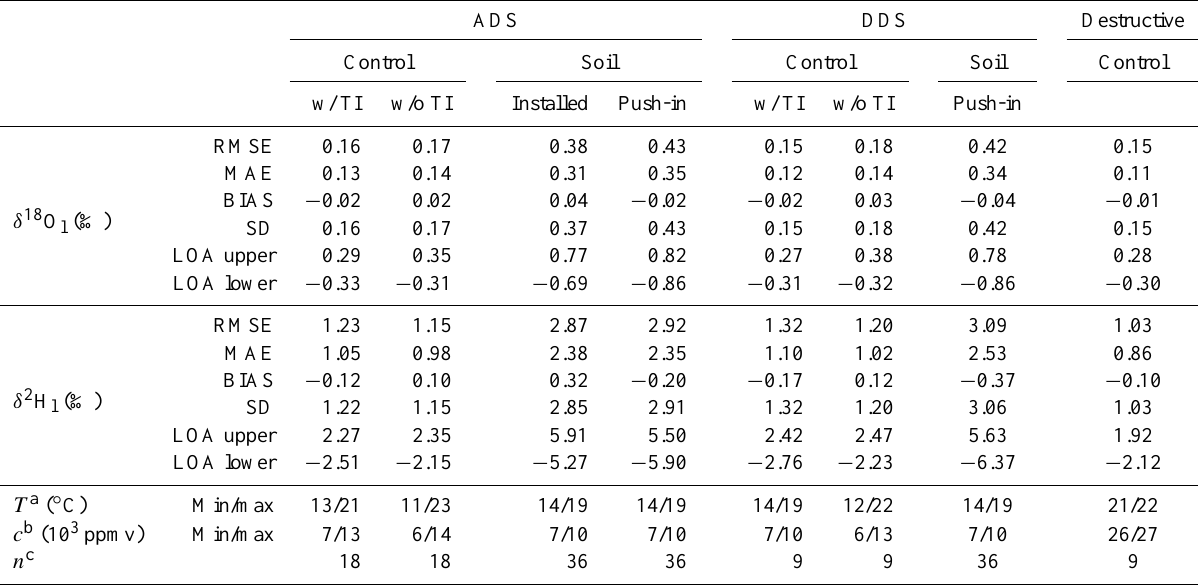
Table 1. Summary statistics of in situ and destructive laboratory-based pore water stable isotope measurements of quality control standards with and without thermo-insulation (TI) and soil profiles. ADS DDS Destructive Control Soil Control Soil Control w/o TI Installed Push-in w/ TI